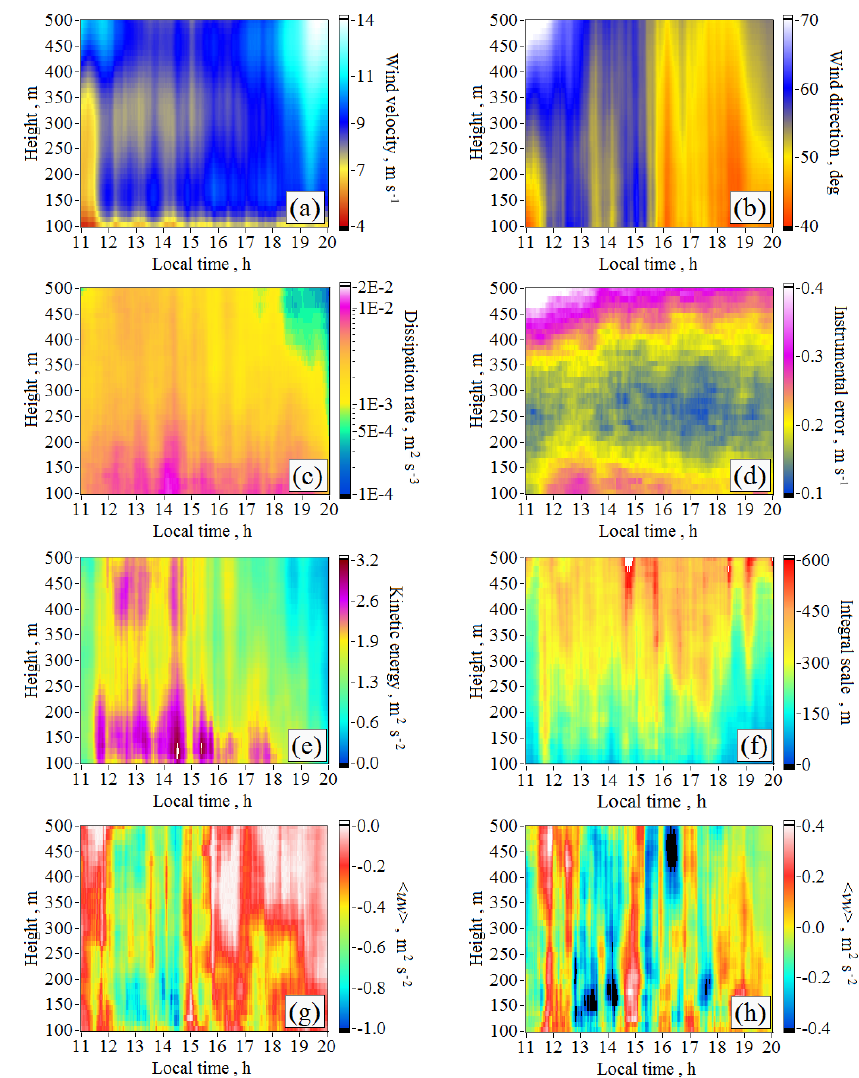
Figure 7. Spatiotemporal distributions of the average wind velocity U (a) , wind direction angle θ V (b) , turbulent energy dissipation rate ε (c) , instrumental error of estimation of the radial velocity σ e (d) , kinetic energy of turbulence E (e) , integral scale of turbulence L V (f) , and momentum fluxes < uw > (g) and < vw > (h) obtained from measurements by the Stream Line lidar on 22 July